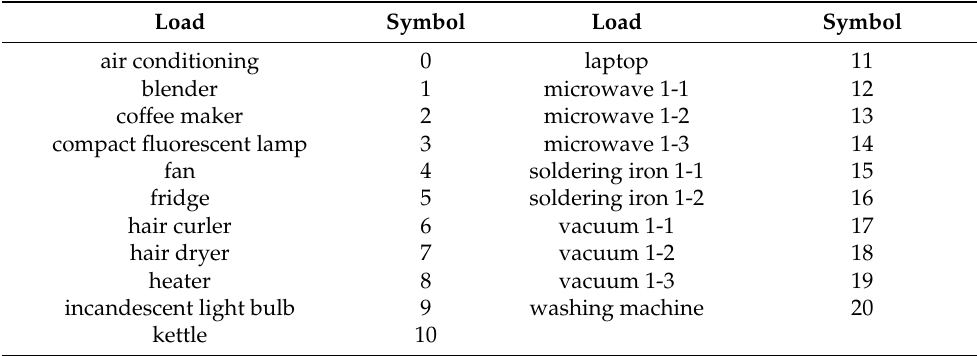
Table 3. Symbols representing the load of the PLAID